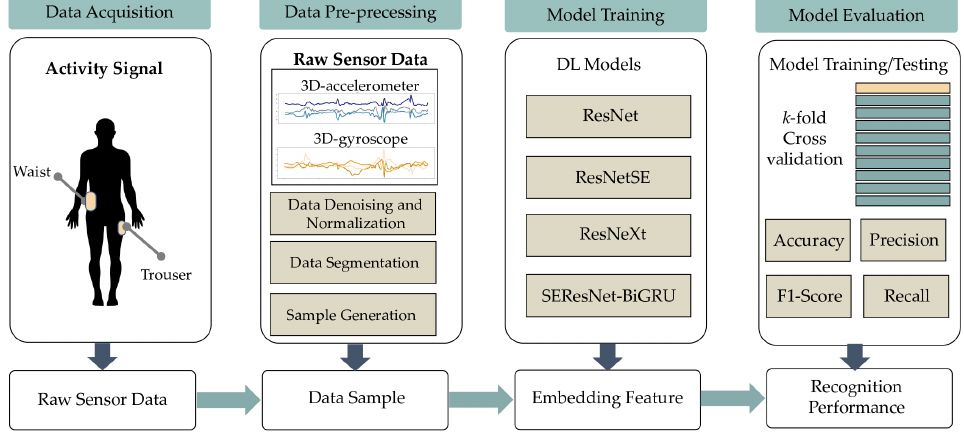
Figure 1. The proposed S-HAR